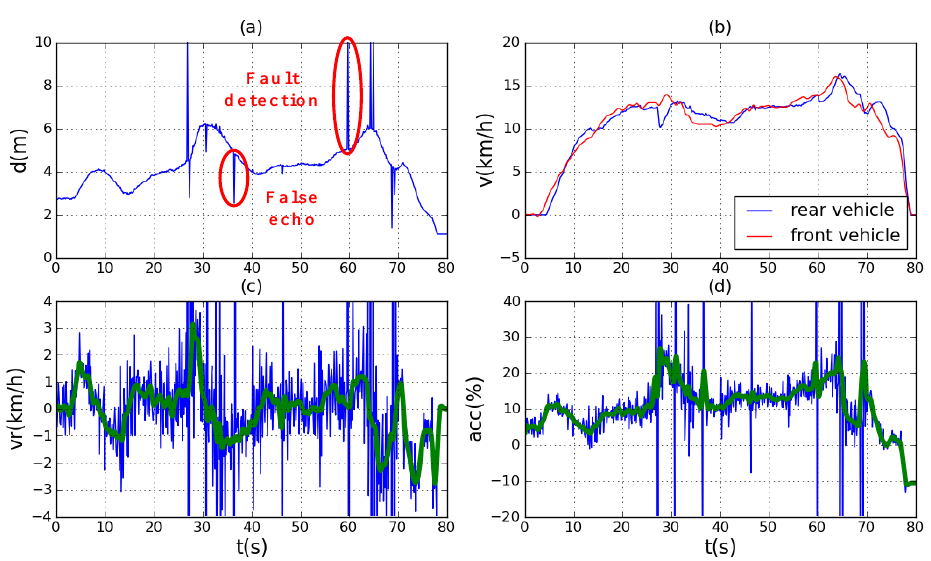
Figure 9. Results of a tracking maneuver performed with the proposed control system. (a) Distance measured with the ultrasonic system. (b) Vehicle speeds extracted from the CAN bus. (c) Relative speed unfiltered and filtered. (d) Actuating signal unfiltered and filtered.